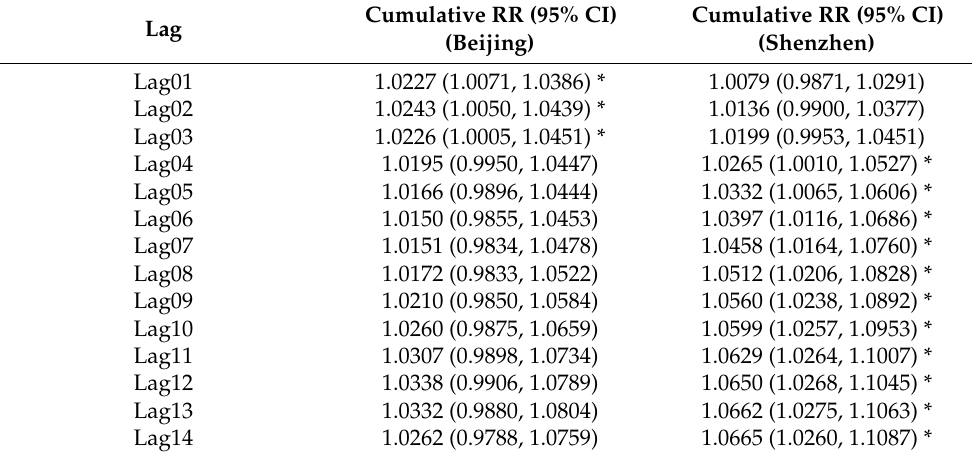
Table 3. Relative risk (RR) values for AECOPD in cumulative lag mode in associations with 10 µ g/m 3 increase in PM 2.5 concentrations in 2013. (Value with * is significant at the 0.05